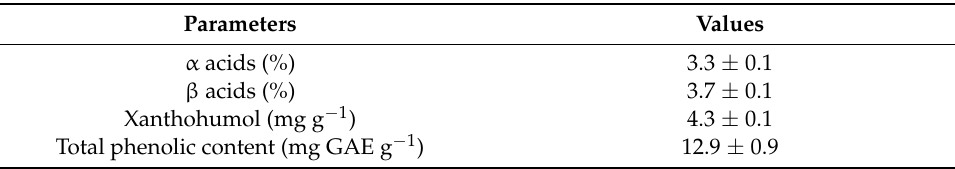
Table 1. Chemical composition of hop extract (mean ± sd; n =